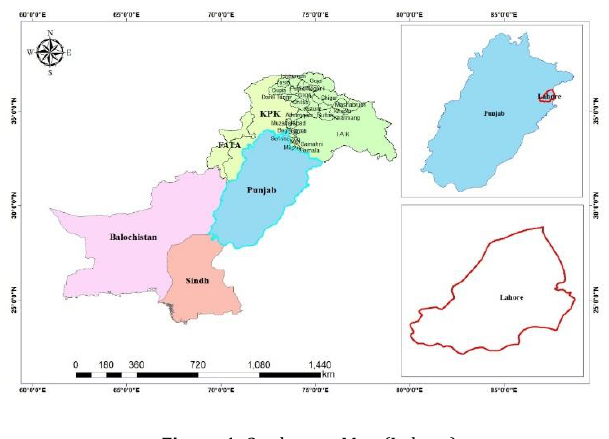
Figure 1: Study area Map (Lahore)